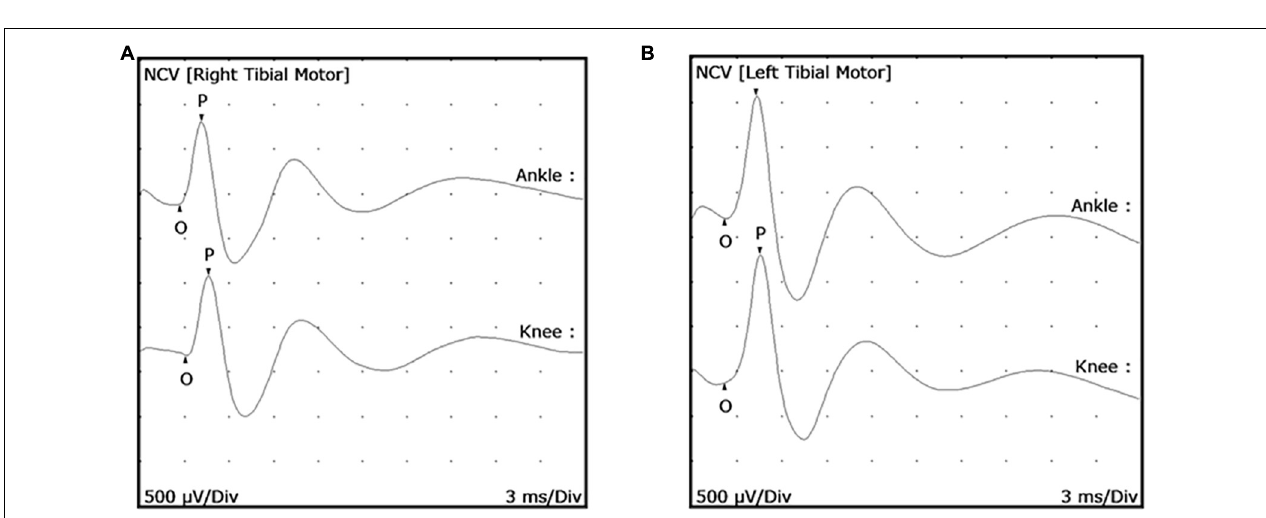
FIGURE 1 | Localization of M. leprae in the posterior tibial nerve of infected armadillos. (A) Posterior tibial nerve showing clumps of intraneural M. leprae (arrows); modified Fite/Faraco stain. Electron micrographs showing M. leprae (M. lep) within unmyelinated (B) and myelinated (C) Schwann cell (SC) located by the axon (AX) in the post-tibial nerve of an armadillo at 24 months post-experimental infection.